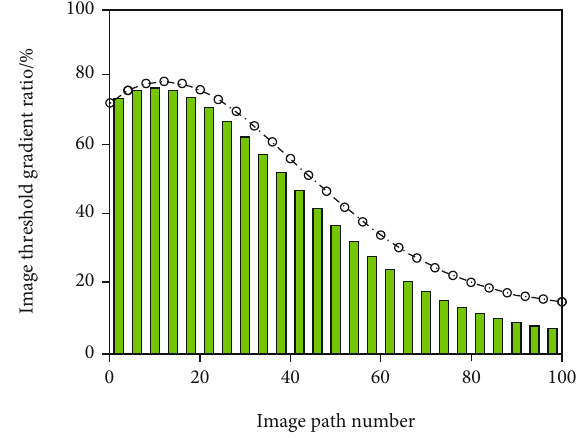
Figure 6: Image threshold parameter gradient denoising e ff ect distribution.